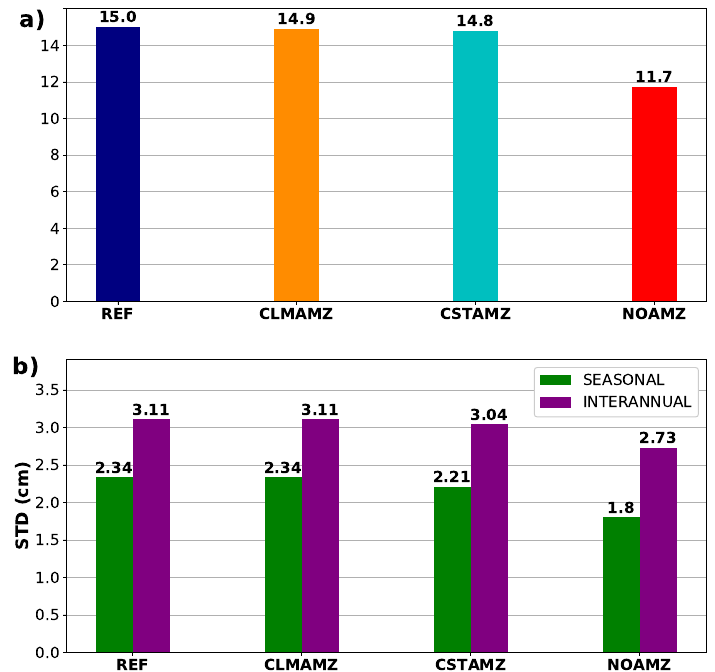
Figure 10. Sea level changes between simulations: ( a ) Mean Dynamic Topography (cm) and ( b ) sea level seasonal and interannual standard deviations (cm), based on monthly series. Quantities are averaged over the diagnosis box. The considered period is